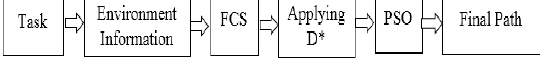
Fig. 3. Proposed planning for the mass point in dynamic environment.